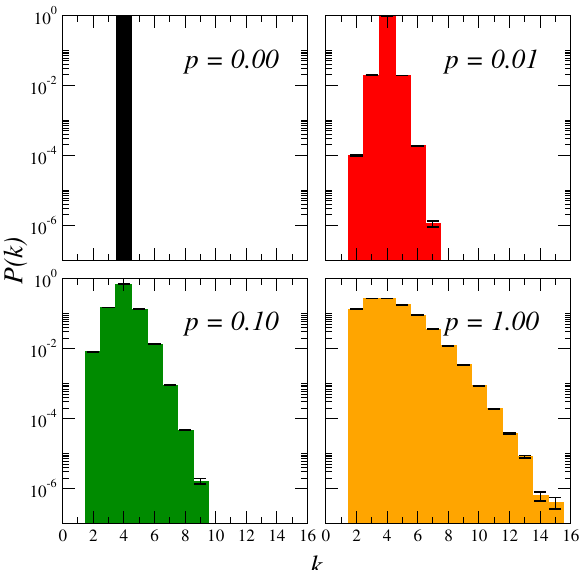
Figure 2. Degree distributions P(k) of complex networks built according to the rewiring scheme for four values of the rewiring probability, p = 0, 0.01, 0.1, 1 (shown in black, red, green and yellow, respectively). Each sub- figure in the panel corresponds to a fixed value of p averaged over a total of 1000 different networks, starting from initial two-dimensional square lattices of size L = 140 for a total of N = 19600 nodes per